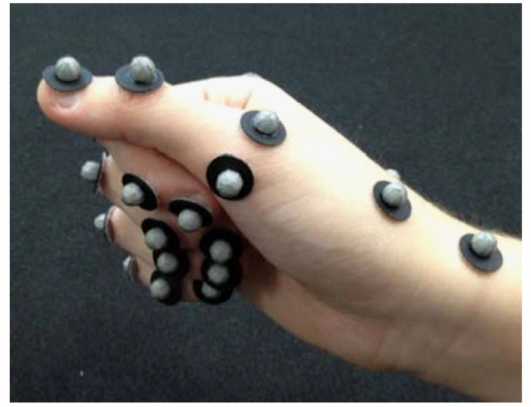
Figure 2. Reference posture for the thumb